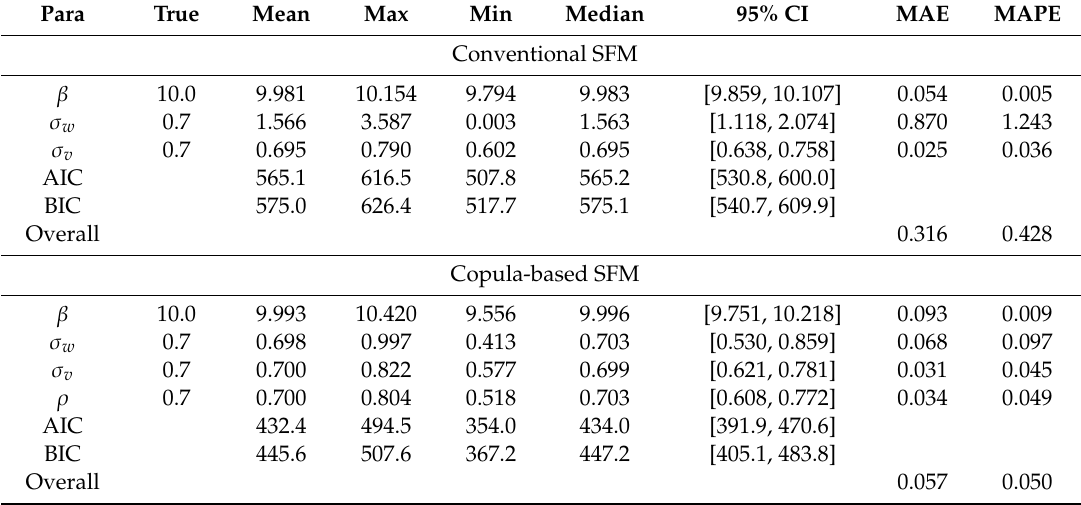
Table 1. Simulation results of the conventional SFM and copula-based